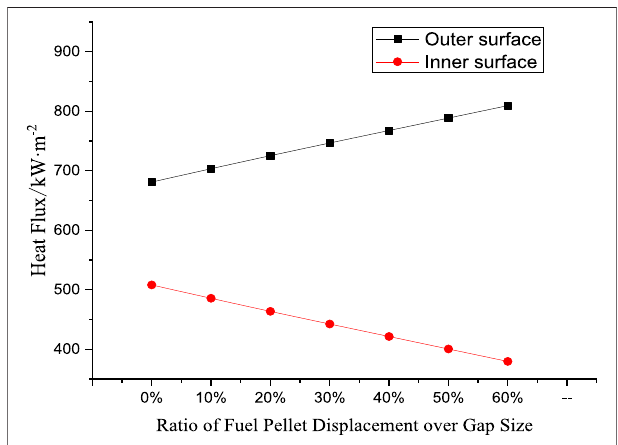
FIGURE13 | Average heat fl ux of inner and outer channel with fuelpellet displacement